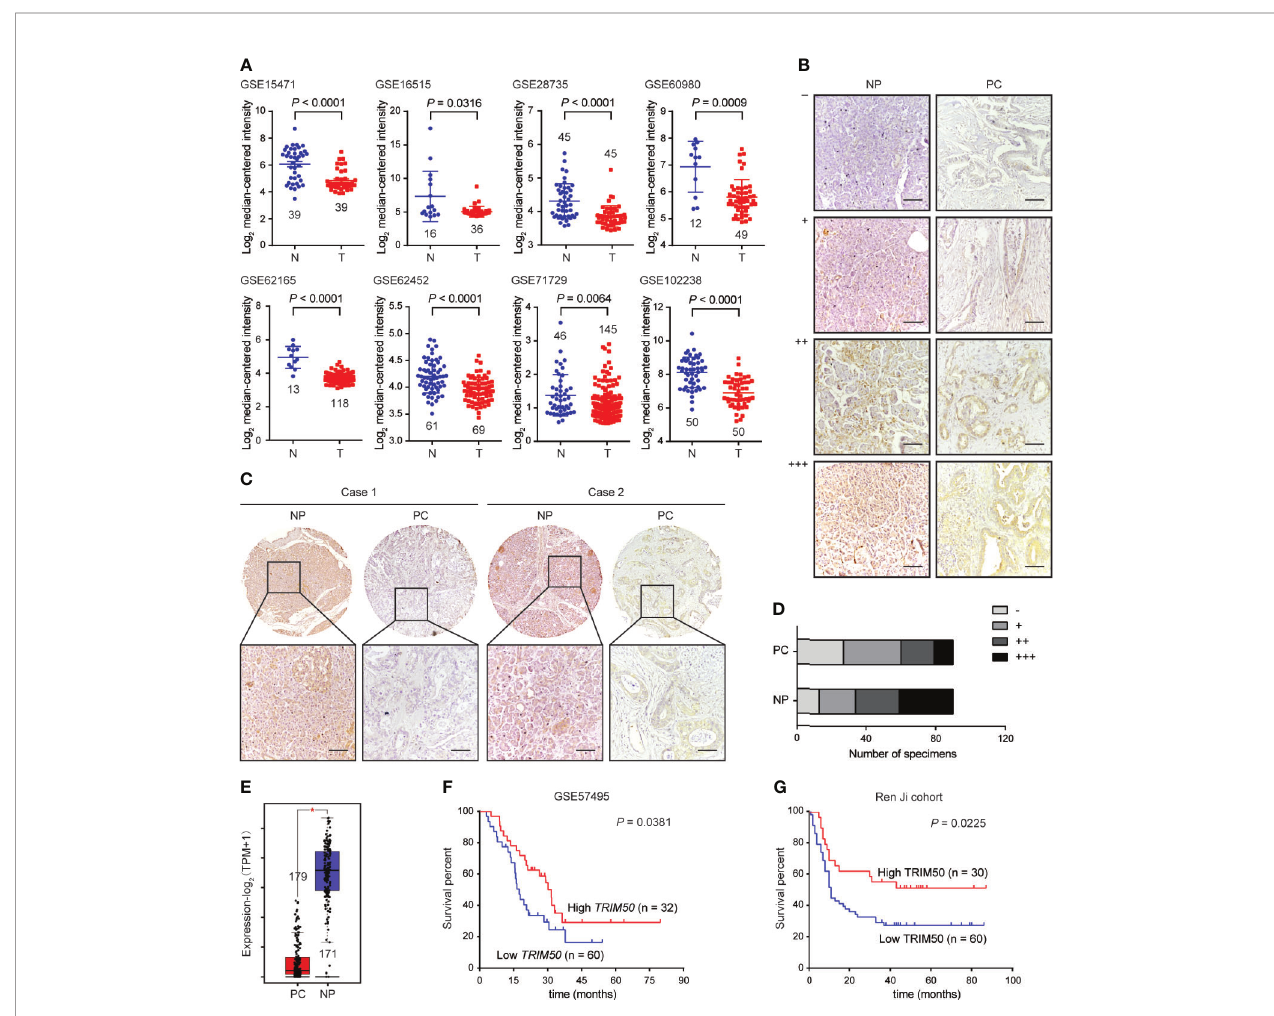
FIGURE 1 | TRIM50 expression in pancreatic cancer tissues and cell lines and its association with prognosis. (A) Comparison of TRIM50 mRNA expression level in pancreatic cancer (T) and normal pancreas (N) tissues based on the data derived from multiple independent GEO datasets. (B) IHC staining of TRIM50 in pancreatic cancer (PC) and normal pancreas (NP) tissues. Representative images of NP and PC tissues with different TRIM50 immunoreactivity displaying no (-), weak (+), moderate (++), or strong (+++). Scale bar: 50 m m. (C, D) Comparison of TRIM50 expression in paired NP and PC tissues. Scale bar: 50 m m. (E) Comparison of TRIM50 mRNA expression level in PC and NP tissues based on the data derived from TCGA cohort and GTEx. (F, G) Kaplan-Meier curves showing signi fi cant association of TRIM50 expression with pancreatic cancer patients ’ survival in GSE57495 (F) and Ren Ji cohorts (G)